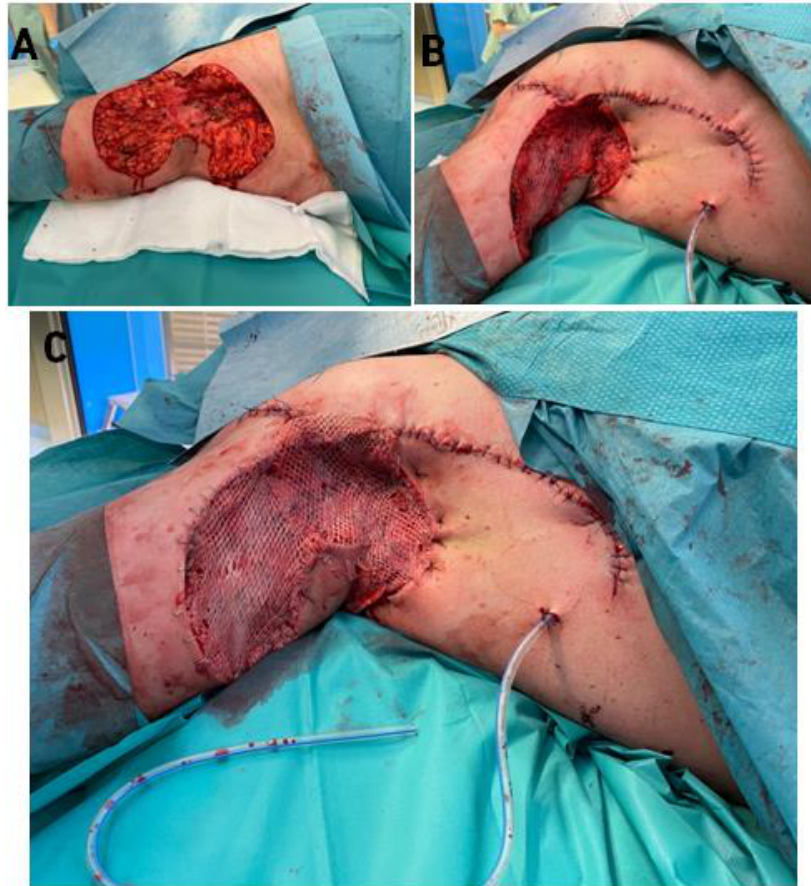
Figure 4. Stages of surgical procedure (case 2); ( A ) — wound after excision, ( B ) — Application of ADM directly to the wound (meshing in ration 1:2.0), ( C ) — total wound closure (co-graft ADM + STSG). Legend: ADM — Acellular Dermal Matrix, STSG — Split thickness skin graft.